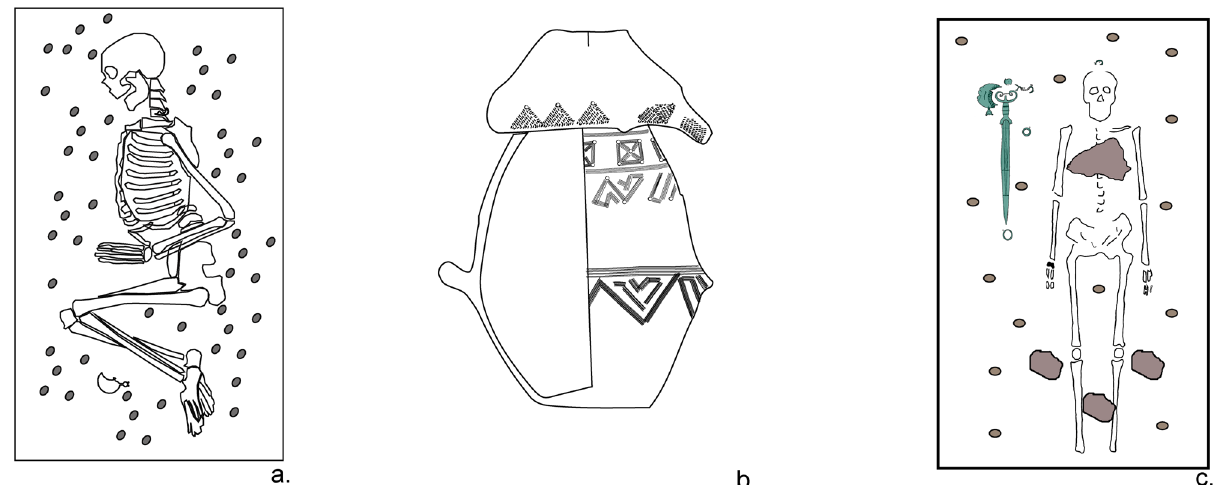
Figure 2. Typical Picene funerary and Fermo funerary traditions. ( a ) Picene burial, Tomb AI18, Porto Sant’Elpidio, adapted from Bergonzi and Ritrecina 64 ; ( b ) a vase with a distinctive neck covered by a